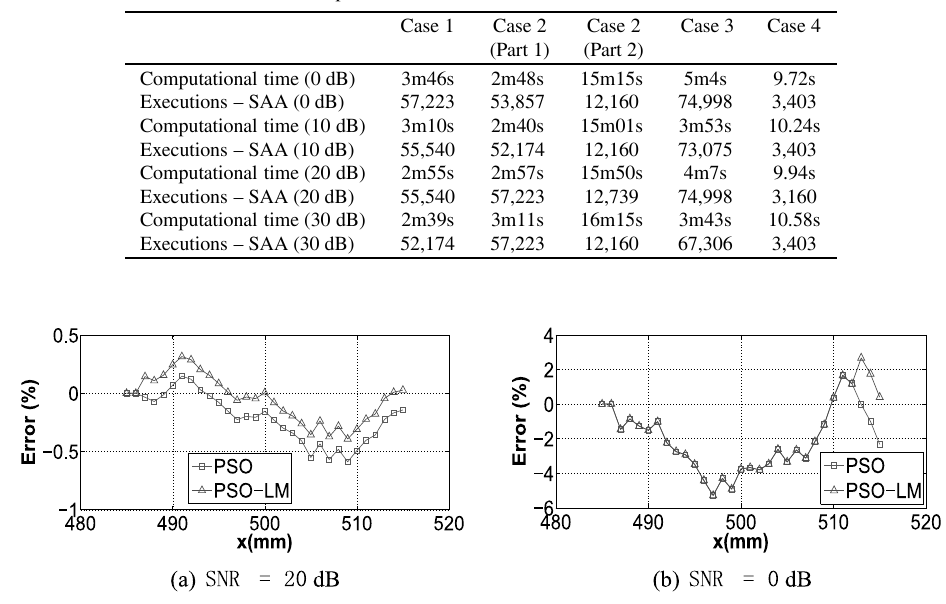
Fig. 16. Relative error in the identi fi cation for a low (0 dB) and moderate (20 dB) levels of SNR, Case 1, a = 25 mm and d = 5 . 0 mm.